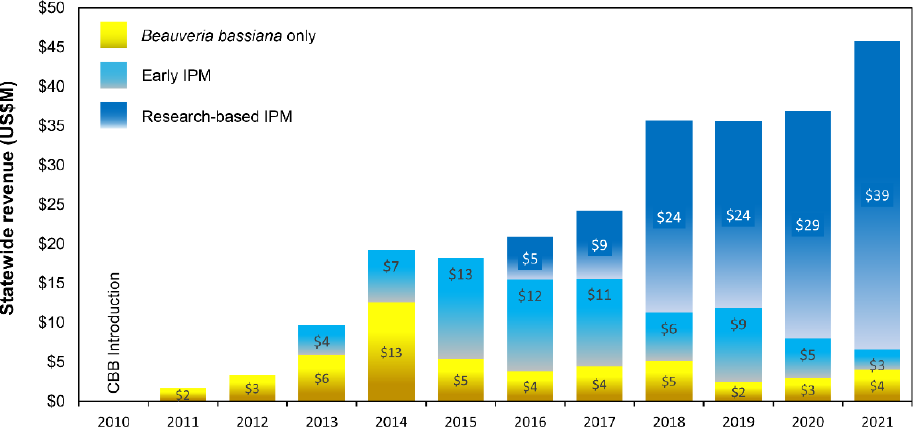
Figure 7. Gain in statewide revenue (USD millions) for Hawaii-grown coffee using three CBB man- agement strategies: B. bassiana only (introduced in 2011), early IPM (introduced in 2013), and re- search-based IPM (introduced in